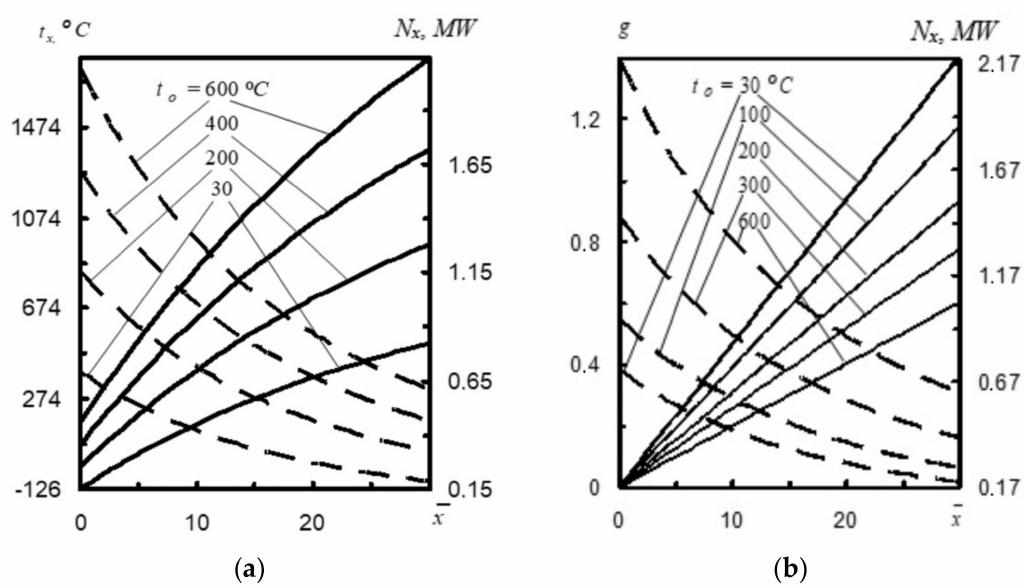
Figure 3. ( a ) Effect of temperature t x (—-) and power N x (- ) depending on the change of nitrogen temperature t 0 , at a different distance x from the nozzle cross-section [1] and ( b ) change of assumed stream mass g (—-) and its power N x (- ) depending on nitrogen temperature t 0 at a different distance x from the nozzle cross section